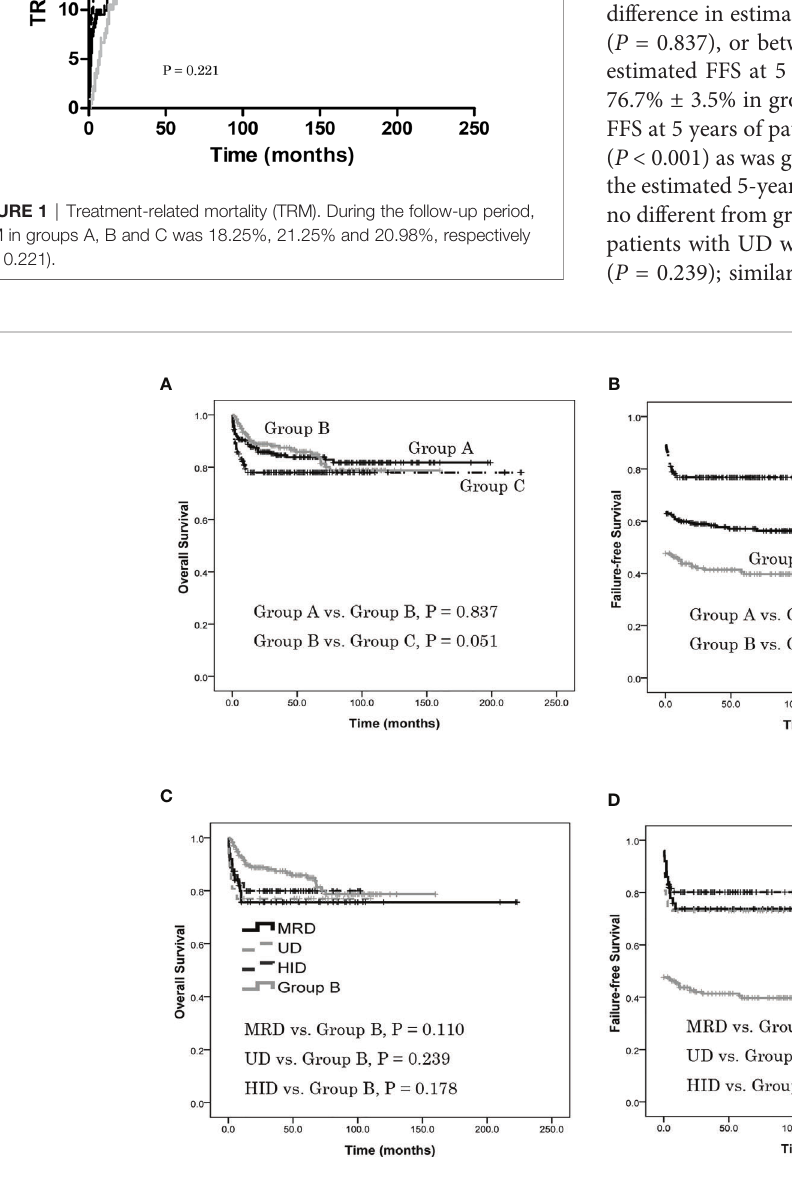
FIGURE 2 | Patients overall survival (OS) and failure-free survival (FFS), as assessed using Kaplan-Meier analysis. (A) The estimated OS at 5 years was 83.8% ± 2.6%, 85.8% ± 2.6% and 77.9% ± 3.4% in groups A, B and C, respectively. There was no difference in estimated 5-year OS between group A and group B ( P = 0.837), or between B and C ( P = 0.051). (B) The estimated FFS at 5 years was 57.1% ± 3.3%, 39.7% ± 3.4% and 76.7% ± 3.5% in groups A, B and C, respectively. The estimated FFS at 5 years of patients in group A was higher than in group B ( P < 0.001) as was group C ( P < 0.0001). (C) In group C, the estimated 5-year OS of patients with MRD was 75.6% ± 6.1%, no different from group B (P = 0.110); the estimated 5-year OS of patients with UD was 76.9% ± 8.3%, no different from group B (P = 0.239); the estimated 5-year OS of patients with HID was 80.5% ± 4.7%, again not different from group B (P = 0.178). There was no difference of estimated 5-year OS in patients with MRD, UD or HID (P = 0.866). (D) In group C, the estimated FFS at 5 years of patients with MRD was 73.7% ± 6.3%, which was higher than in group B (P < 0.0001); the estimated FFS at 5 years of patients with UD was 73.1% ± 8.7%, which was higher than in group B (P = 0.003); the estimated 5-year FFS of patients with HID was 80.2% ± 4.7%, which was also higher than group B (P < 0.0001). There was no difference of estimated 5-year FFS in patients with MRD, UD or HID (P =